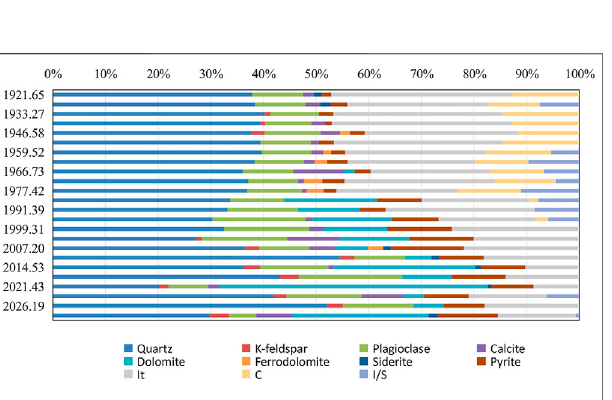
FIGURE 4 | (A) The lithofacies ternary diagram of the Niutitang shale of Well YX1; (B) Mineralogical ternary diagram of shales.